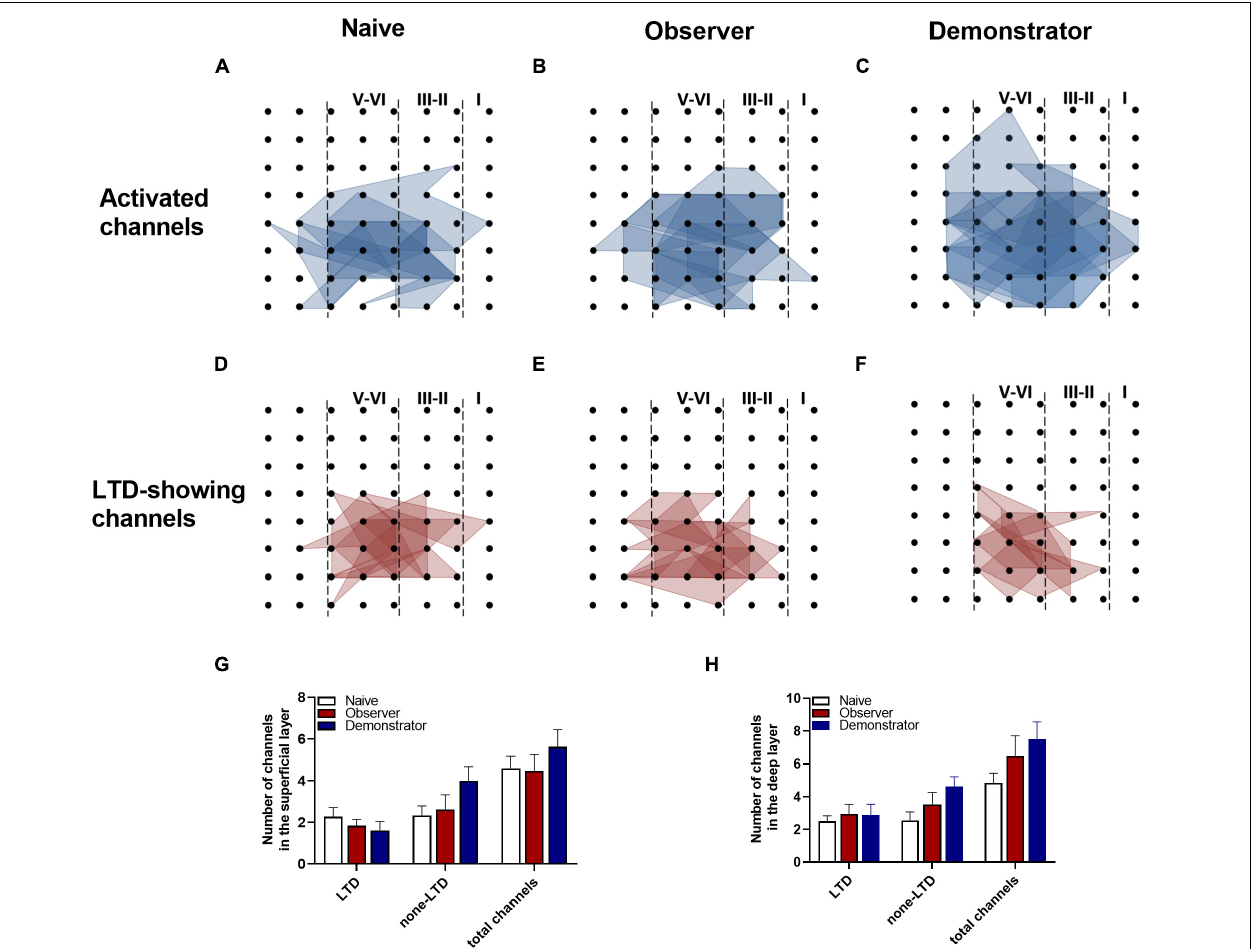
FIGURE 7 | Spatial representation of aIC LTD. (A–F) The polygonal diagram of activated (blue) and LTD-showing (red) channels within aIC after LFS in naïve (A,D) , observer (B,E) , and demonstrator mice (C,F) ; (G,H) Average number of channels of naïve, observer, and demonstrator mice in the superficial (G) and deep layers (H) . Data are shown as mean ± SEM (Naïve n = 8 slices of 7 mice, observer n = 12 slices of 8 mice, and demonstrator n = 4 slices of 4 mice) and compared by two-way ANOVA analysis followed by unpaired t -test, vs. naïve.